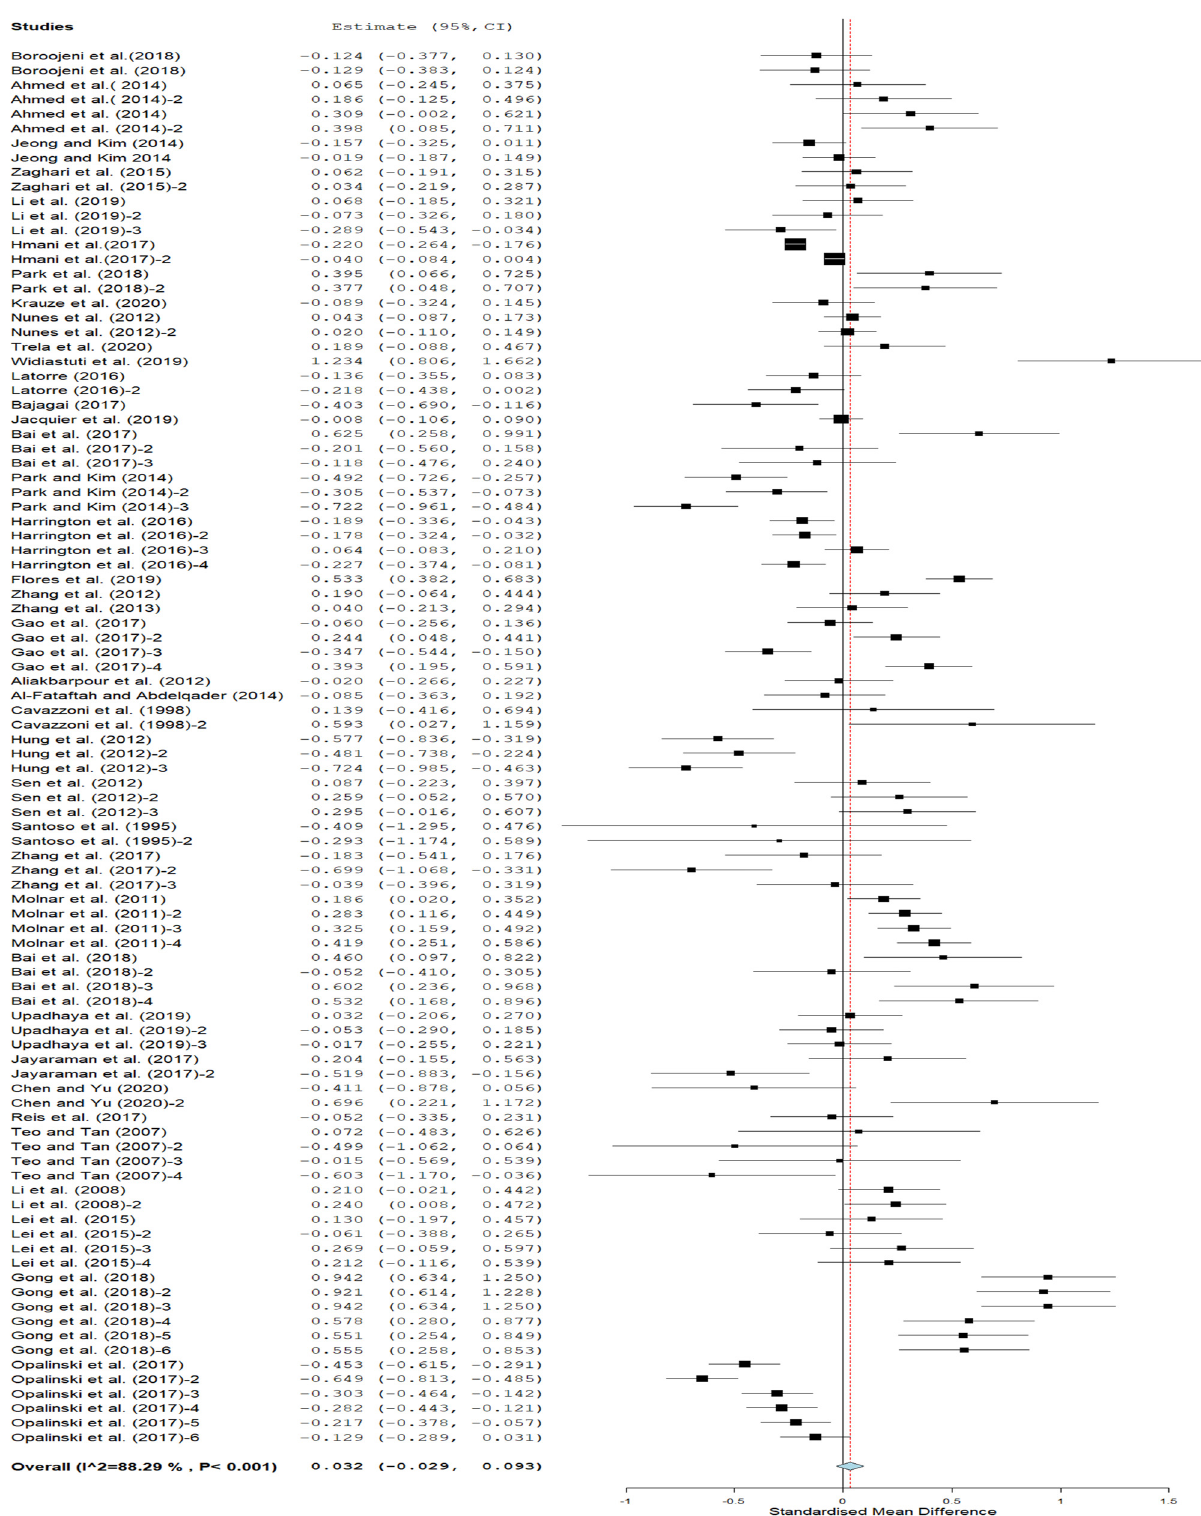
Figure 3: In fl uence of Bacillus supplementation on feed intake in broiler chickens. Pooled estimation ( SMD ) = 0 ( thick line ) suggests no e ff ect, SMD > 0 suggests an increase in variables of interest over the controls, and SMD < 0 denotes a decline in variables of interest over the controls. The dotted line with a diamond denotes the cumulative e ff ect size across all studies used for the meta -